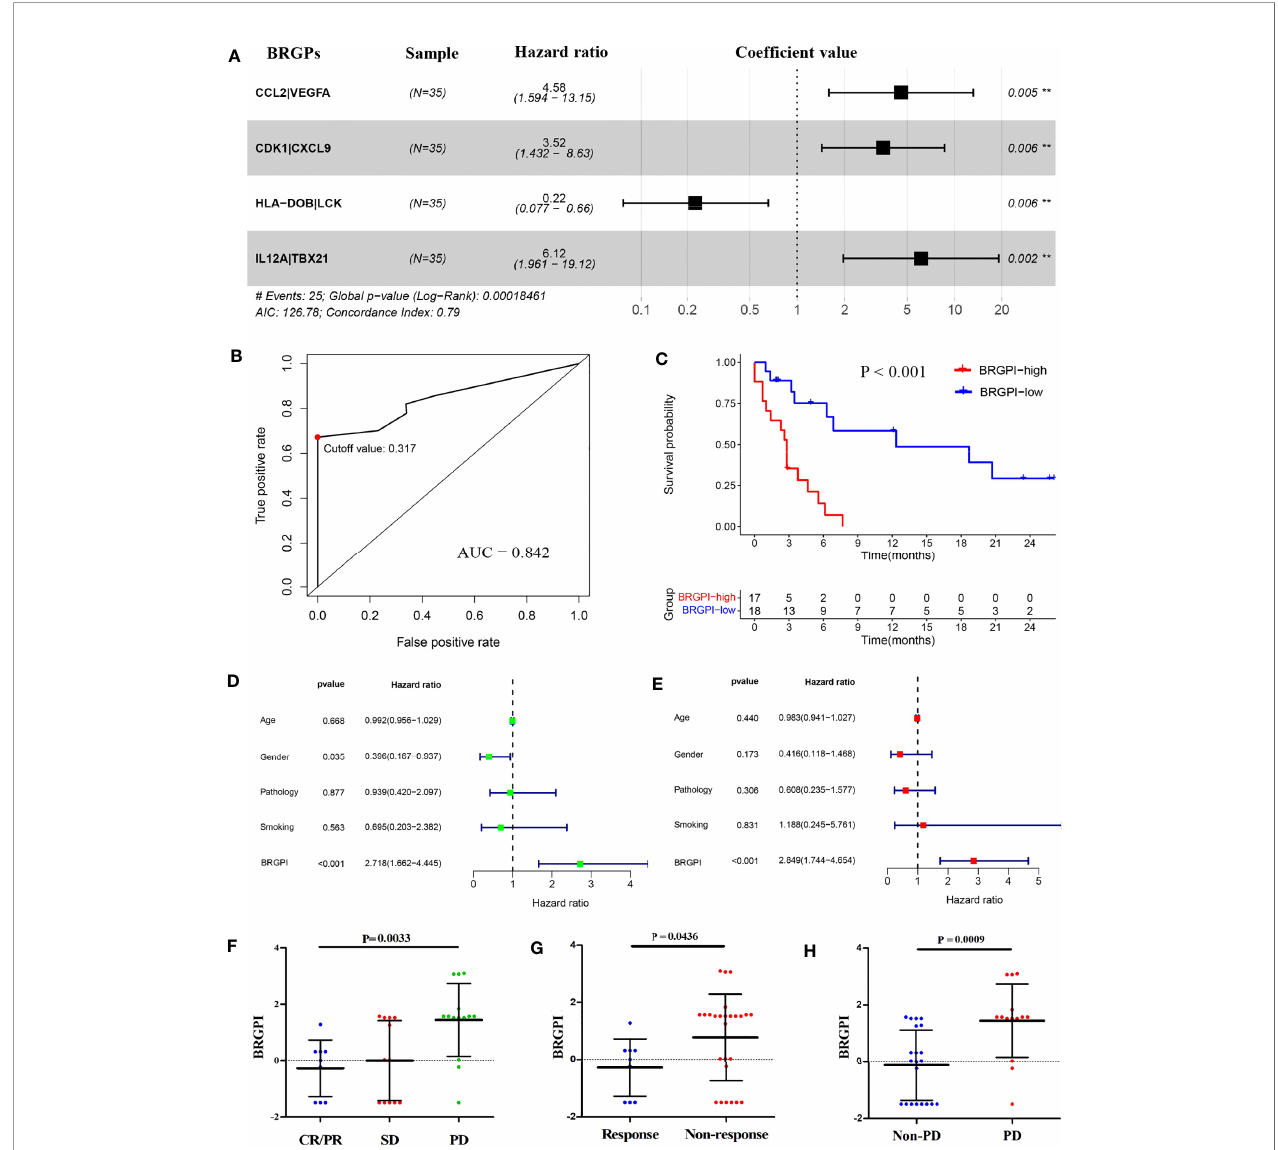
FIGURE 1 | Construction and de fi nition of the BRGPI for patients with NSCLC treated with anti-PD-1 immunotherapy in the training cohort. (A) Prognostic values of four selected BRGPs. (B) ROC analysis of the BRGPI for progression-free survival. (C) Survival curve of progression-free survival for patients with NSCLC treated with anti-PD-1 immunotherapy according to the BRGPI. (D, E) Univariate (D) and multivariate (E) regression analyses of the associations between BRGPI and clinical variables for the predictive ability of progression-free survival. (F) The distributions of the BRGPI scores among the patients receiving CR/PR, SD, and PD. (G) The distributions of the BRGPI scores between the two groups (response and non-response). (H) The distributions of the BRGPI scores between the two groups (Non- PD and PD). **P <